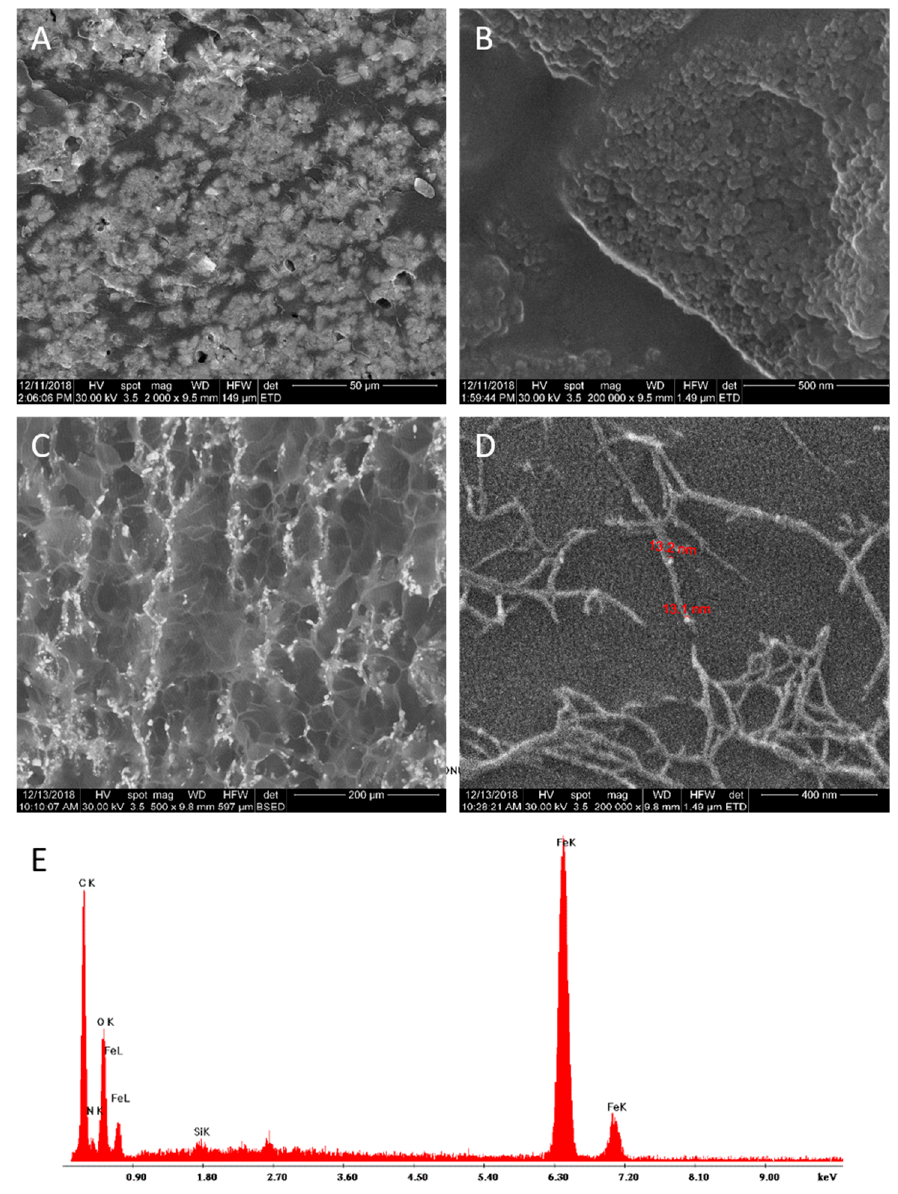
Figure 9. SEM micrographs of PAA-MMNPs 50:50 hydrogel ( A , B ).and lyophilized PAA-MMNPs 50:50 hydrogel ( C , D ); Energy dispersive X-ray (EDX) spectrum ( E ).